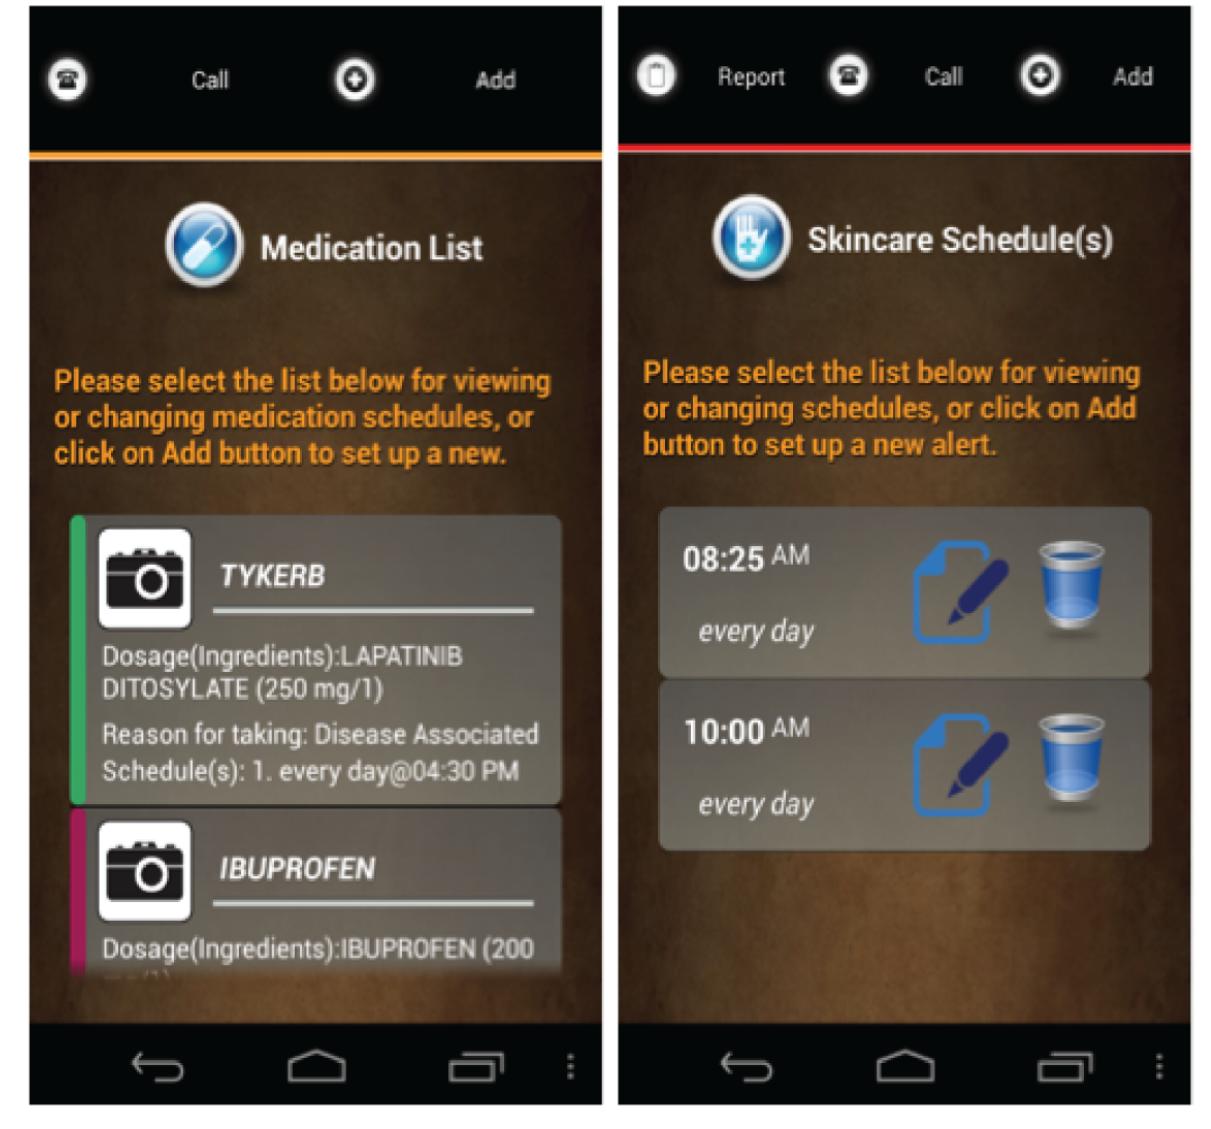
Figure 3. Screenshots of the use of color-coding at the app level. (Source: Created by the